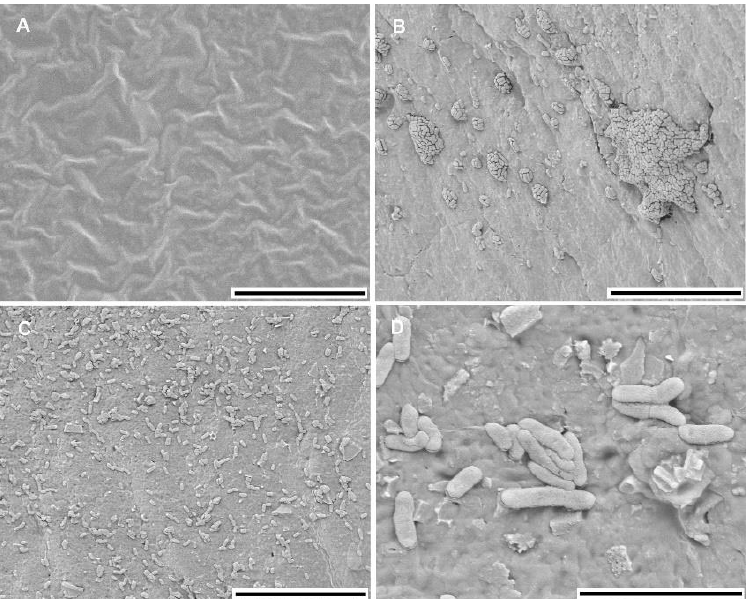
Figure 1. Scanning electron microscopy images showing biofilm formation of the urinary catheter isolate E. ludwigii CEB04 on the surface of a silicon catheter. Catheter control ( A ), different catheter areas with representative biofilm formation ( B , C ) and a detailed view of surface-attached cells ( D ). Scale bars = 20 µm (A, B, C) and 5 µm (D).